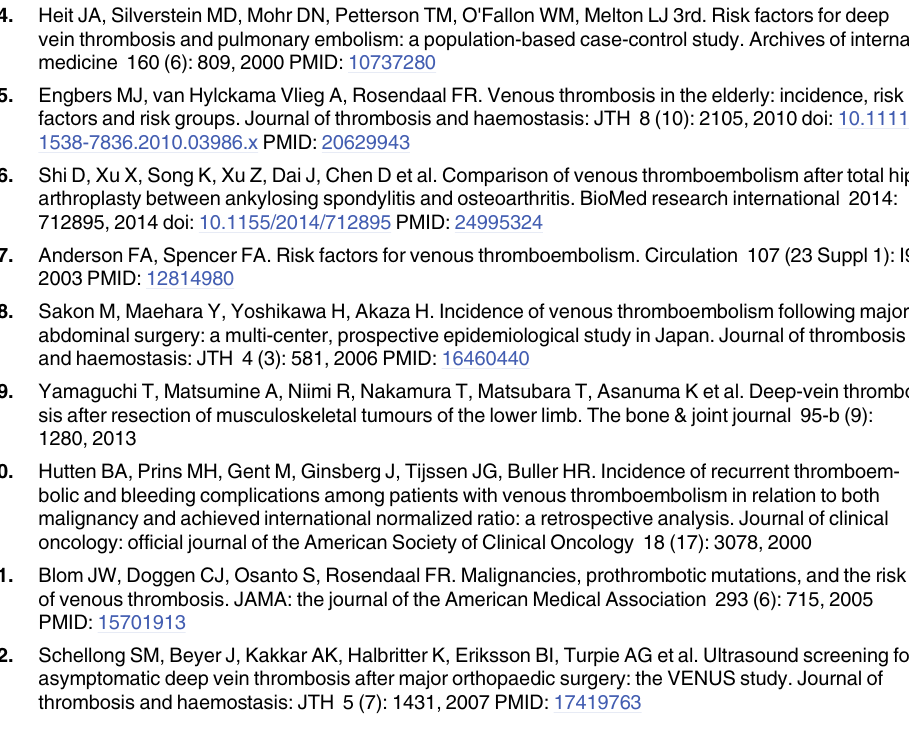
PLOS ONE | DOI:10.1371/journal.pone.0158215 June 28,